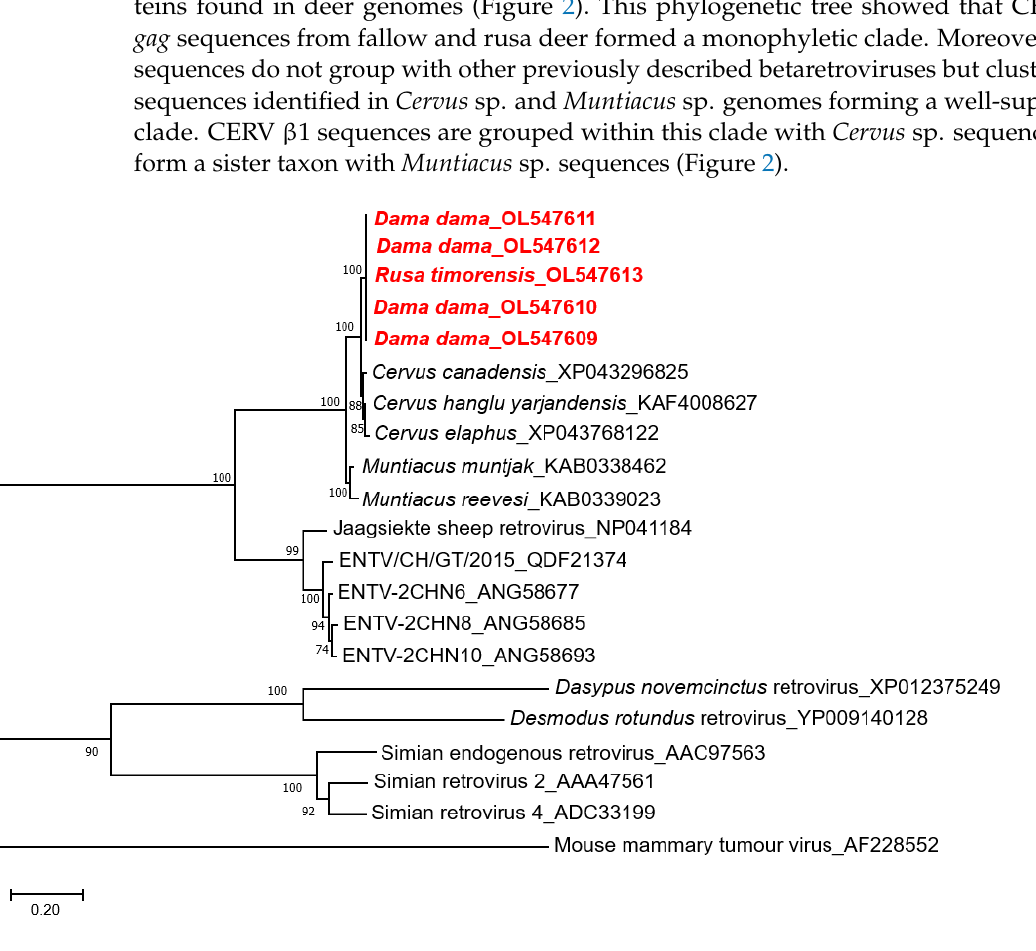
Figure 2. Phylogenetic analysis of CERV β1 sequences obtained by next-generation sequencing (in red), related sequences in deer genomes, and representative members of the genus Betaretrovirus . The tree was generated based on the gag protein by the maximum-likelihood method, and JTT + G + I substitution model with 1000 bootstrap replicates. Bootstrap values >70% are displayed at the tree branches. The scale bar indicates amino acid substitutions per site. ENTV: Enzootic nasal tumour virus.